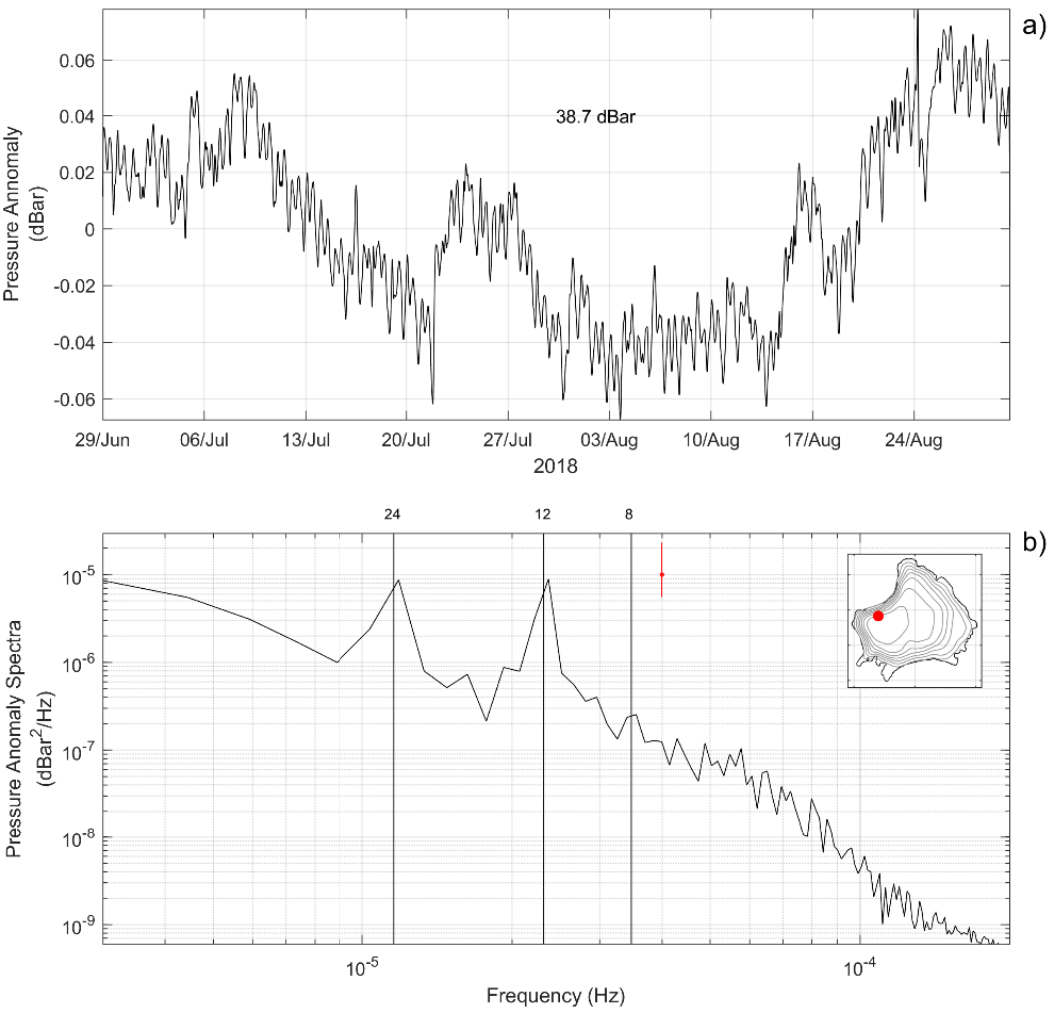
Figure 12. Pressure time series from a HOBO-level ( a ), field campaign conducted in July–August. Power spectral density (in dBar 2 / Hz) and the location of the pressure level sensor in the lake ( b ). The red bar is the 95% confidence interval.